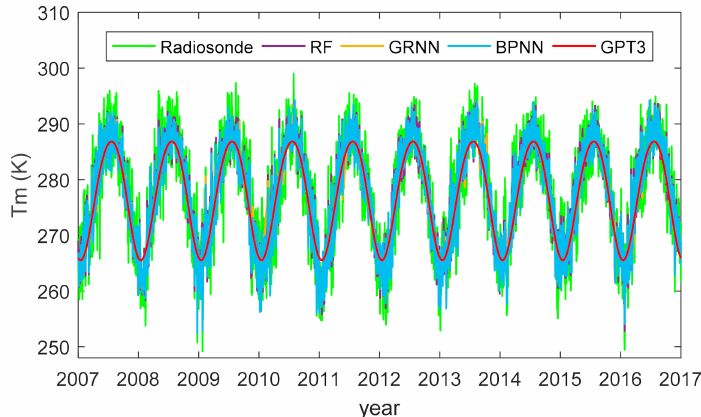
Figure 11. T m time series estimated from different models and radiosonde observations at the station CHM00057083 (34.71 ◦ N, 113.65 ◦